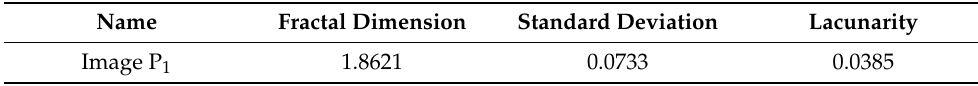
Table 1. Fractal characteristic calculation of picture P 1.